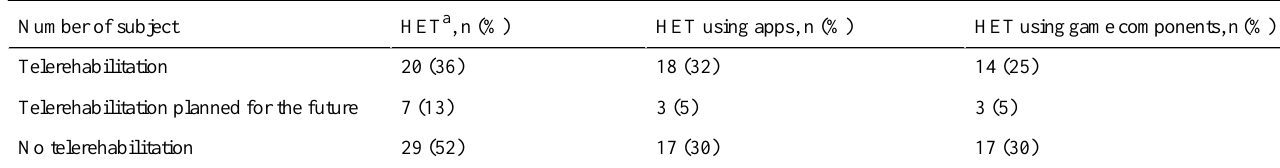
Table 3. Health-enabling technologies with telerehabilitation combined with apps and game